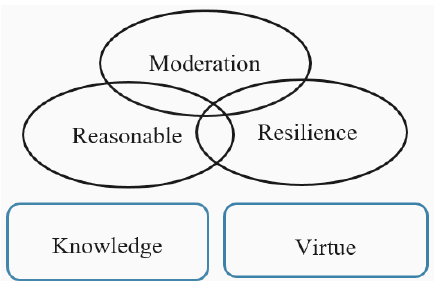
Figure 1. Sufficiency Economy Philosophy Concept